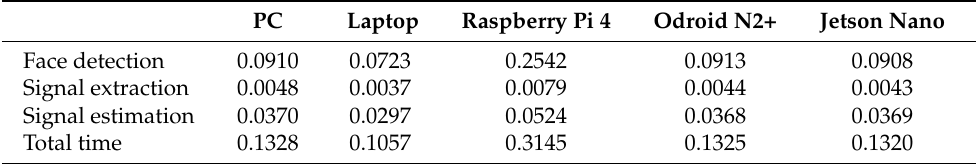
Table 3. Average execution times (sec) for each pipeline step.